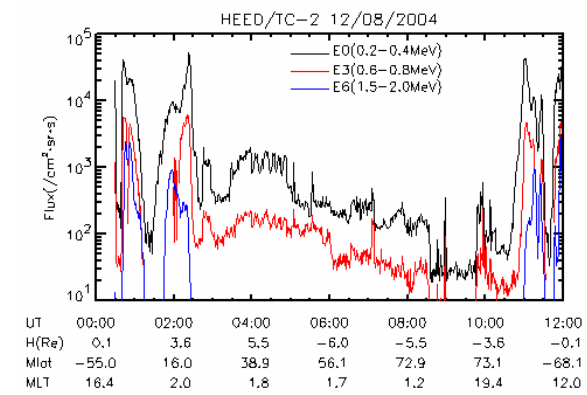
Fig. 14. The D ST index and high energy electron flux (0.2–1.0MeV and 1–10MeV) observed by HEED/TC-2 on 14 September 2004.